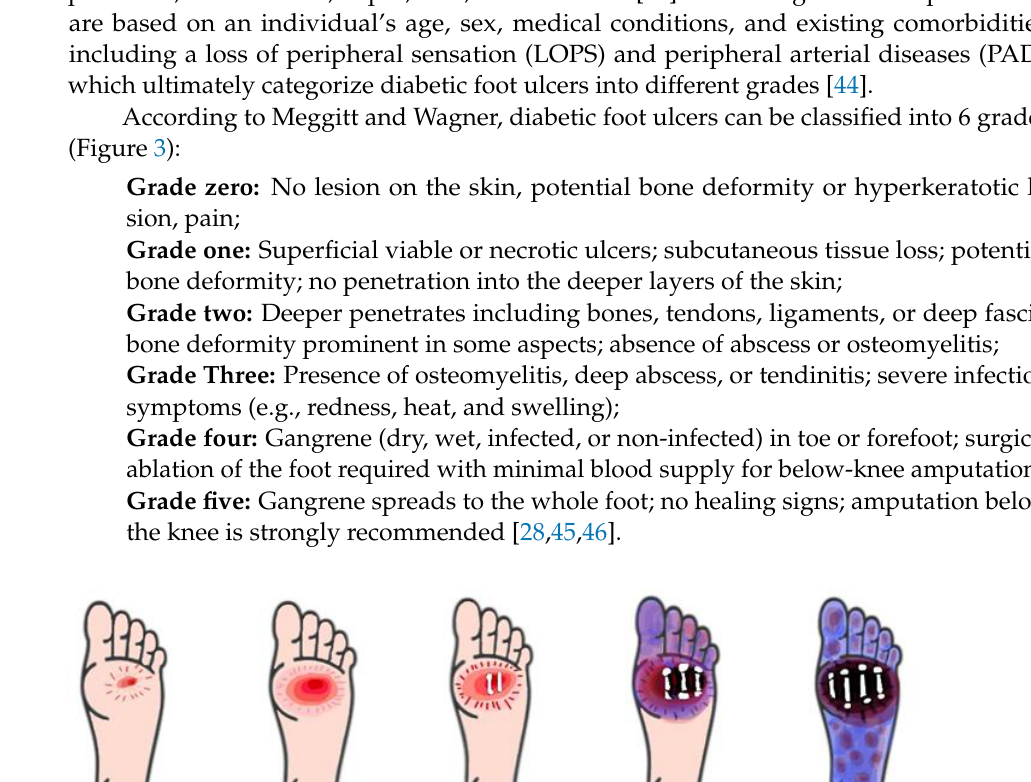
Figure 3. Diabetic foot ulcers are categorized using the Wagner–Meggitt classification. Grade 0 means no break in the skin. Grade 1 indicates a superficial ulcer. Grade 2 indicates a deep ulcer. Grade 3 shows the presence of osteomyelitis. Grade 4 is identified as forefoot gangrene. Grade 5 is recognized as complete foot exposure to gangrene.